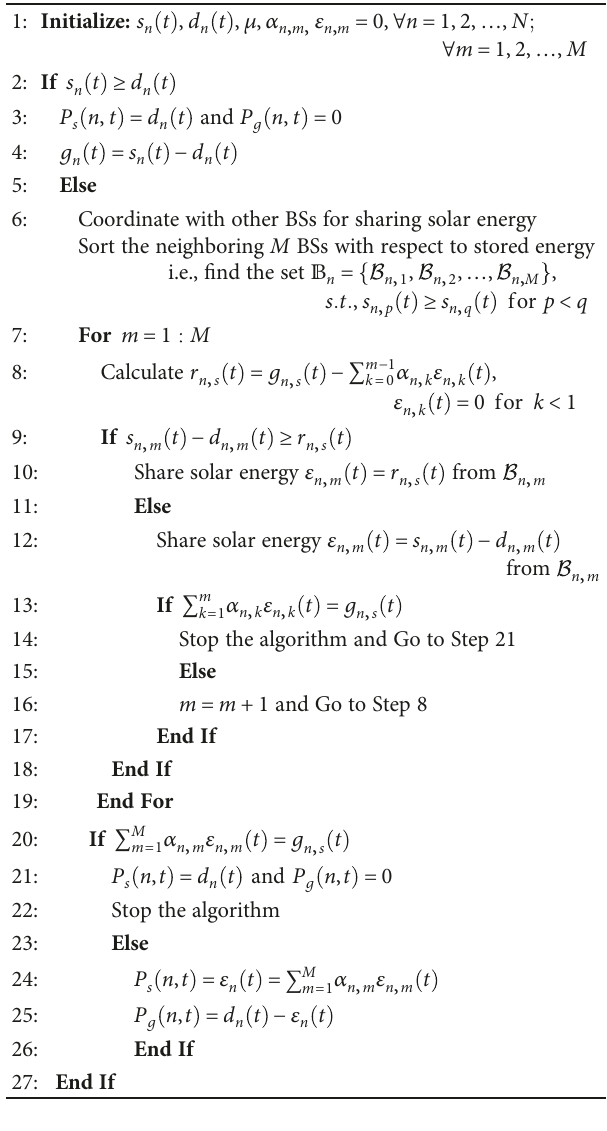
Table 3: Pseudo code of the proposed energy sharing algorithm for n th BS n